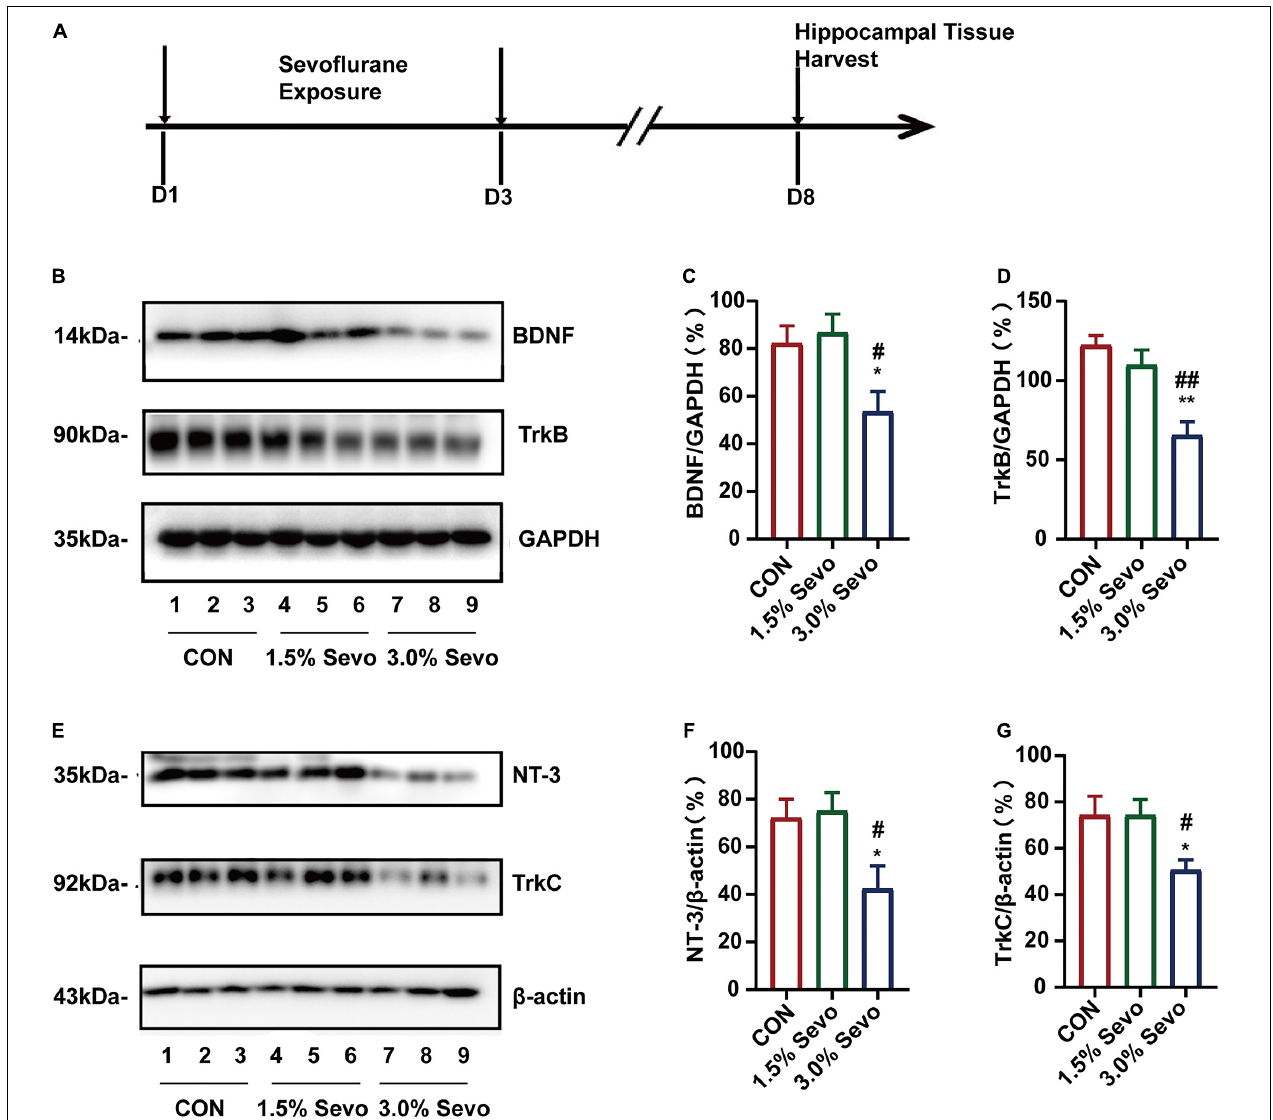
FIGURE 5 | Sevoflurane exposure induces the reduction of BDNF/TrkB and NT-3/TrkC in the hippocampi of aged mice. (A) Timeline of the western blot experimental procedure. (B) Representative WB images of BDNF and TrkB expression in aged mice. Quantitative analysis of BDNF (C) and TrkB (D) . GAPDH was used as an internal standard. (E) Representative WB images of NT-3 and TrkC expression in aged mice. Quantitative analysis of NT-3 (F) and TrkC (G) . β -actin was used as an internal standard. Values are the mean ± S.E.M. * p < 0.05, ** p < 0.01 compared with the CON group. # p < 0.05, ## p < 0.01 compared with the 1.5% Sevo group ( n = 9/group). D, days of experimental procedure; BDNF, brain-derived neurotrophic factor; TrkB, tyrosine receptor kinase B; NT-3, Neurotrophin-3; TrkC, tyrosine receptor kinase C; CON, control group; 1.5% Sevo, 1.5% sevoflurane group; 3.0% Sevo, 3.0% sevoflurane group.